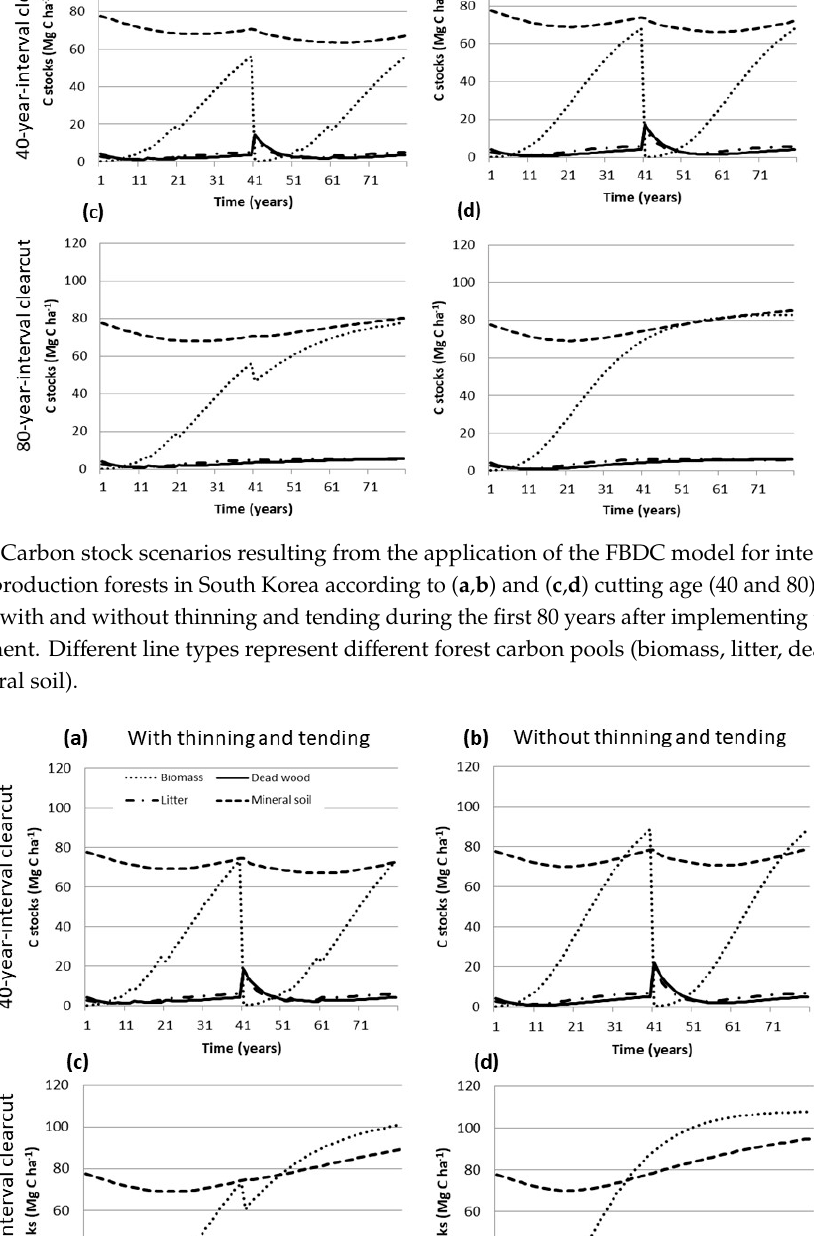
Figure 2. Carbon stock scenarios resulting from the application of the Forest Biomass and Dead organic matter Carbon (FBDC) model for low biomass production forests in South Korea according to ( a , b ) and ( c , d ) cutting age (40 and 80 years) and ( a , c ) and ( b , d ) with and without thinning and tending during the first 80 years after implementing the forest management. Different line types represent different forest carbon pools (biomass, litter, dead wood, and mineral soil).